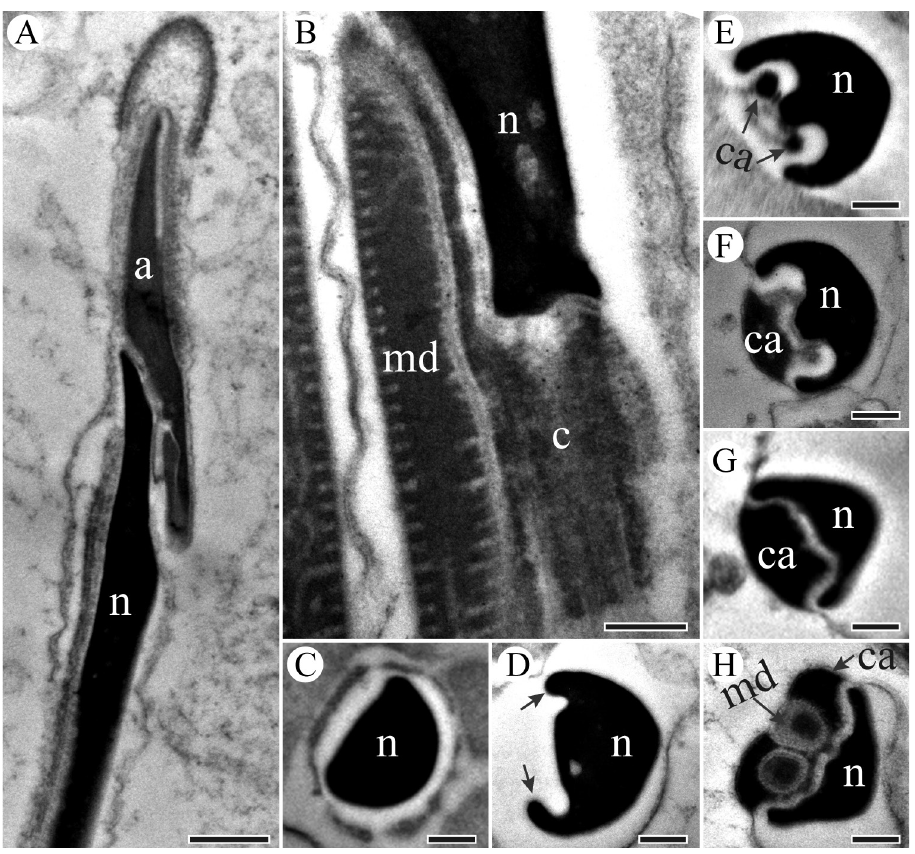
Figure 8. TEM micrographs of sperm neck region of P. kaempferi . A Longitudinal section showing head region, showing conical acrosome (a) and tapered nucleus (n) B Longitudinal section of nucleus-flagellum transition region, showing nucleus (n), mitochondrial derivative (md) and centriole (c) C Cross-section of nucleus (n) with a deltoid appearance D Cross-section through the mid-neck region, showing an invagina- tion at one side of the nucleus (n) developing two ridges (arrowed) E–G Cross-sections through neck region, showing centriolar adjunct (ca) and nucleus (n). H Cross-section through the mid-neck region, showing nu- cleus (n), mitochondrial derivatives (md) and centriolar adjunct (ca). Scale bars: 500 nm ( A ), 200 nm ( B–H